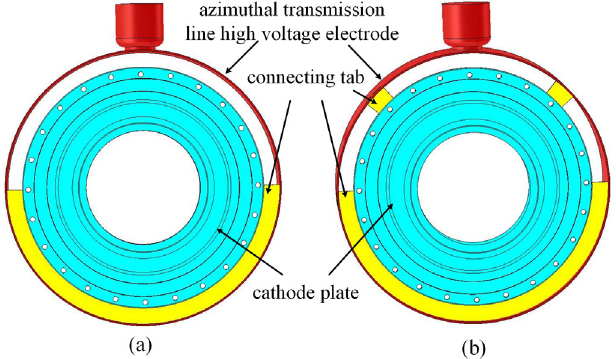
FIG. 3. Two examples of connecting tab configuration. (a) One continuous tab on the lower half circle allows conduction from the azimuthal transmission line to cathode plate, (b) there are two tabs on the upper half circle extending from (cid:2) 40 degrees to (cid:2) 50 degrees and one continuous tab on the lower half circle. The angles are measured in each direction from the midpoint of the oil elbow. The connecting tab forces the current injected onto the azimuthal transmission line to spread away from the feed